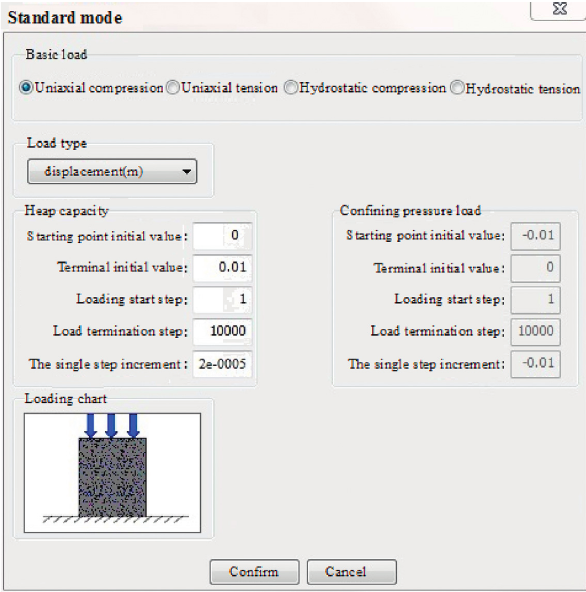
Figure 3: Model displacement loading method.